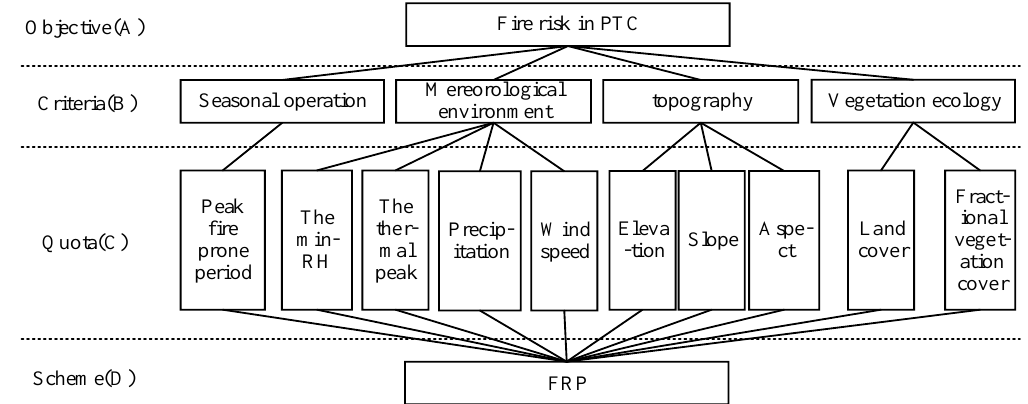
Figure 4 . The general hierarchical structure constructed by